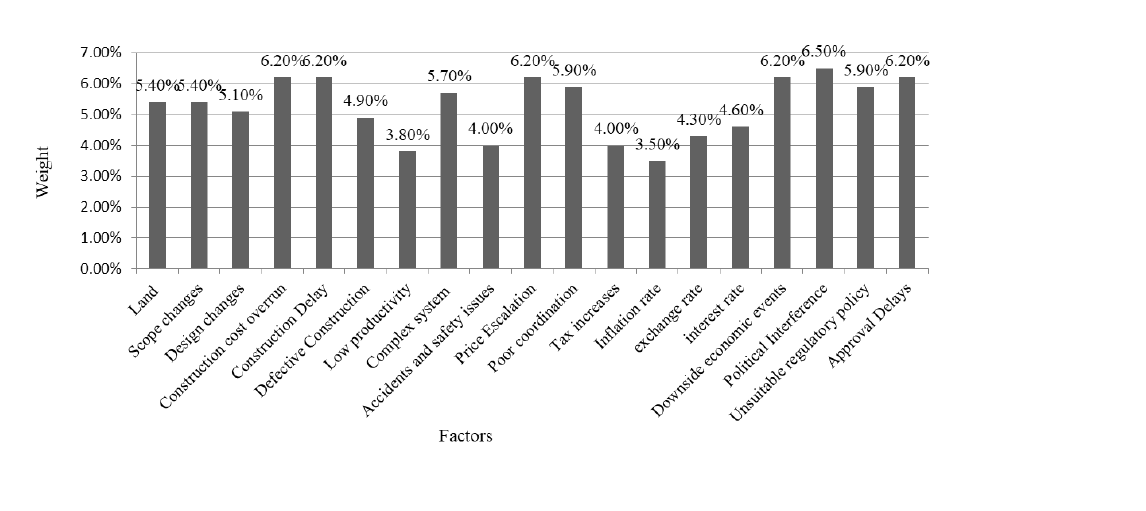
Figure 4. Weights